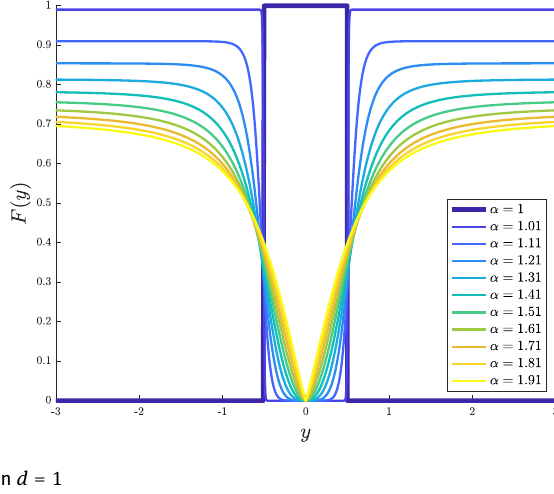
Fig. 1: Self-similar profiles when d =